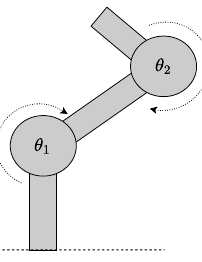
Figure 2: 2-link manipulator